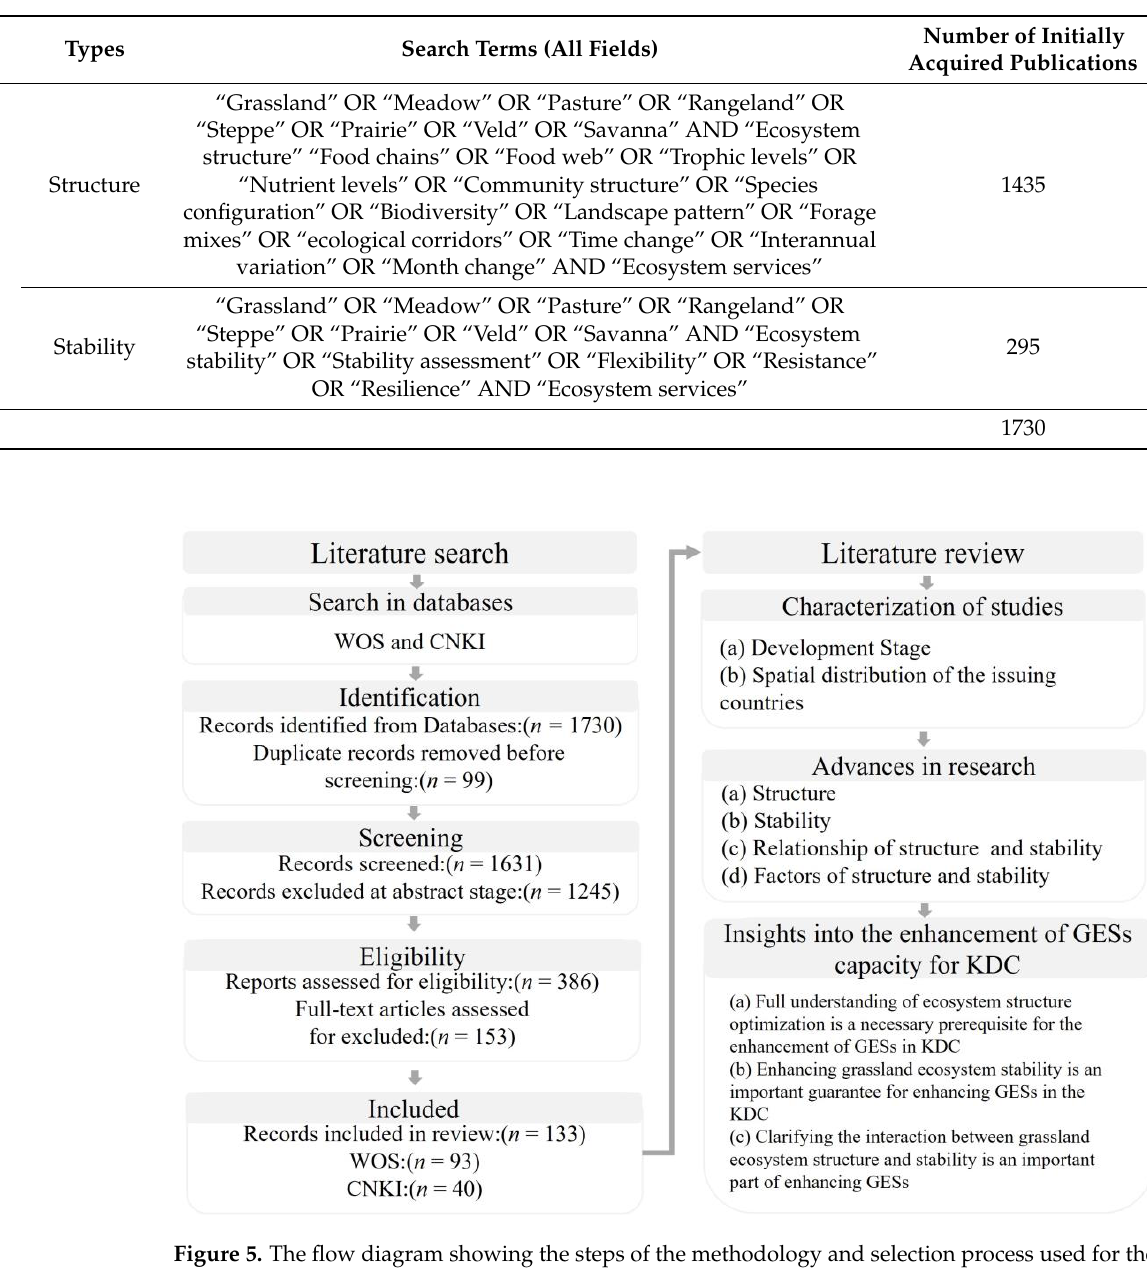
Table 2. Literature search terms and results.